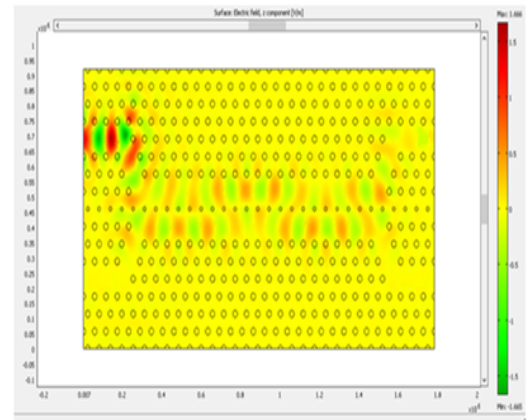
Figure 6: An all-optical switch in linear state